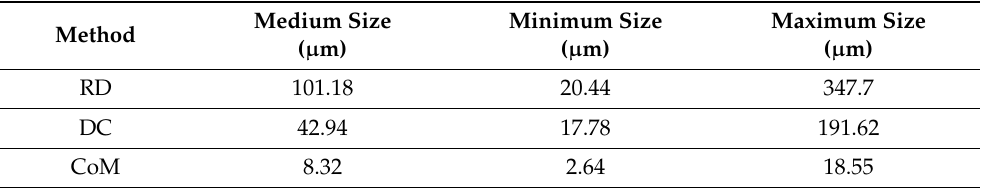
Table 8. Values of the measurements ( µ m) between components.